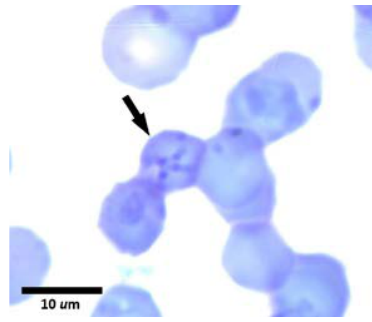
Figure 1: Serum blood samples collected from the black rhino Akhona, on 27 April 2020, while in the holding facilities at Addo Elephant National Park, South Africa; note the haemolysed appearance of the serum